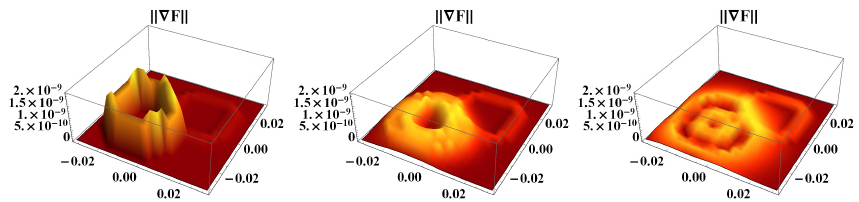
Figure 7. Evolution of the field ∇ F for the times 0, 7 and 28 days respectively.